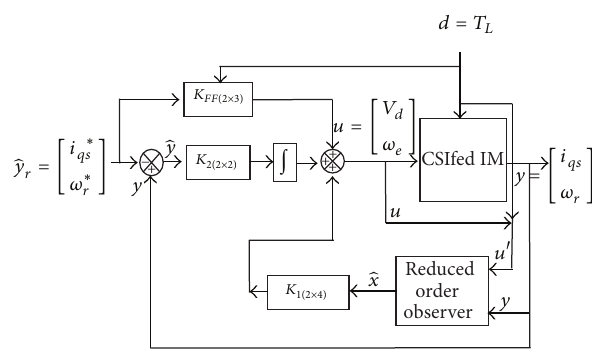
Figure 6: Equivalent circuit of CSI-IM section.